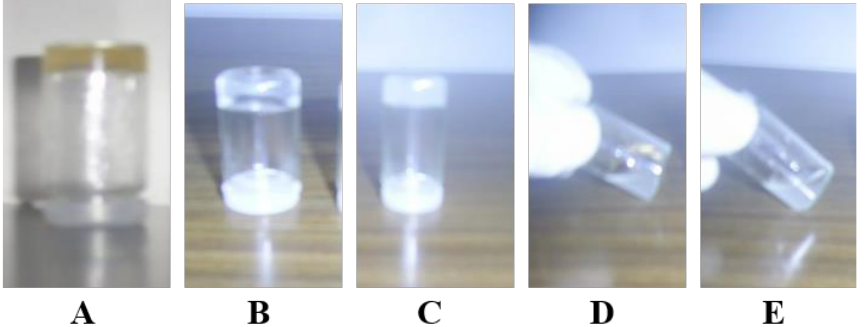
Figure 1. Photos of self-assembling hydrogel based on CD-chol/Ad inclusion complexation: ( A ) 8armPEG20k-chol/8armPEG20k-CD, ( B ) 8armPEG20k-Ad/p β -CD, ( C ) 8armPEG20k-chol/p β -CD, ( D ) 8armPEG-OH/p β -CD, and ( E ) 8armPEG20k-chol/native β